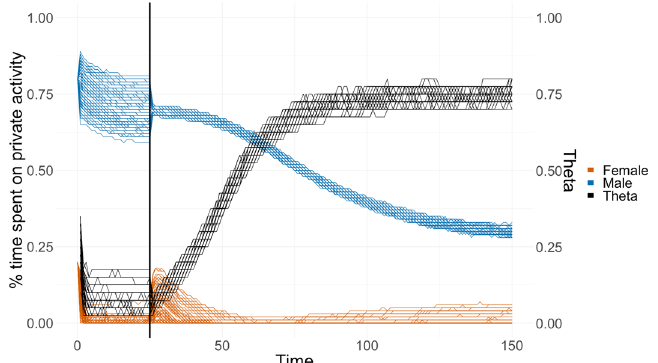
Figure 4. Time series of one simulation run with the IHM under the Conformist Males condition with a wage change of w f = 0.2 , marked with a vertical line at t = 25 . The y-axis shows the percentage of private activity being done by female agents (red) and male agents (blue), in addition to θ (the percentage of private good being traded between agents within households, in black). Individual red and blue lines correspond with single agents, while each black line represents the θ of one household (i.e., agent